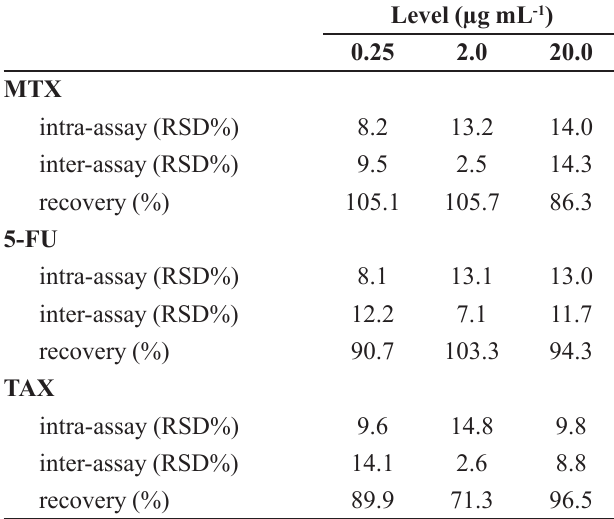
TABLE IV - Intra-assay (repeatability) and inter-assay (intermediate precision) tests, evaluated by the relative standard deviation (RSD%) and recovery of the liquid-liquid extraction for 5-fluorouracil (5-FU) and paclitaxel (TAX) and the solid phase extraction for methotrexate (MTX), in gloves analysed by the proposed